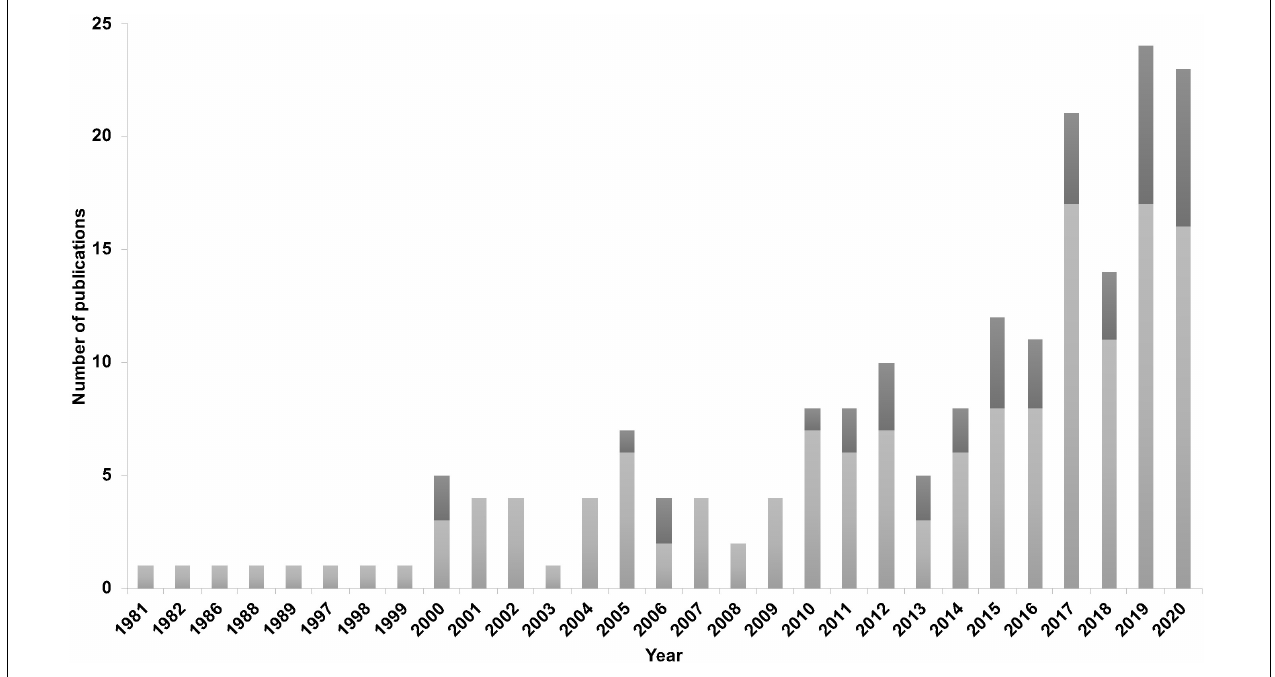
FIGURE 2 | Number of retrieved studies investigating humpback whales and environmental drivers between 1981 and 2020. Dark gray bars indicate mention of climate change or climate shift in the studies.